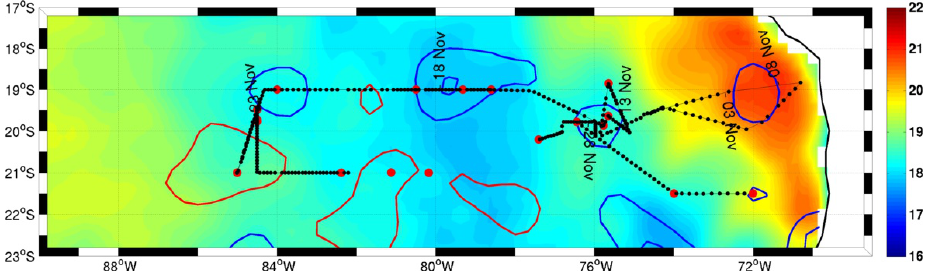
Fig. 1. SST ( ◦ C) from AVHRR for 18 November 2008 (color contours) and ± 5cm Sea Level anomaly contours (line contours) from AVISO during VOCALS cruise period. The cyclonic eddies are marked as blue contours and the anticyclonic ones as red. The NOAA ship Ron Brown cruise track from 1 to 30 November 2008 is shown as points where the 438 UCTD (black dots) and CTD (large red dots) casts were taken.